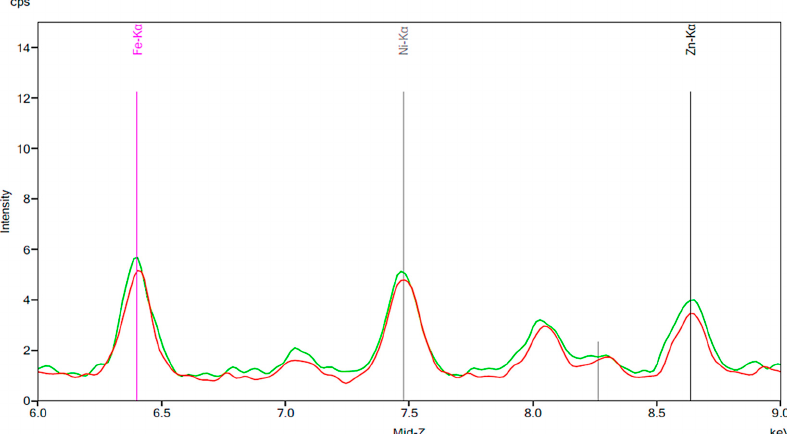
Figure 2. The figure is a portion of the spectrum for a sample of the coffee which was used for the experiments discussed in this paper. This portion is taken from energies ranging from 6.0 KeV to 9.0 KeV plotted against intensity on the y-axis in units of counts per second (cps). Materials 2020 , 13 , x FOR PEER REVIEW